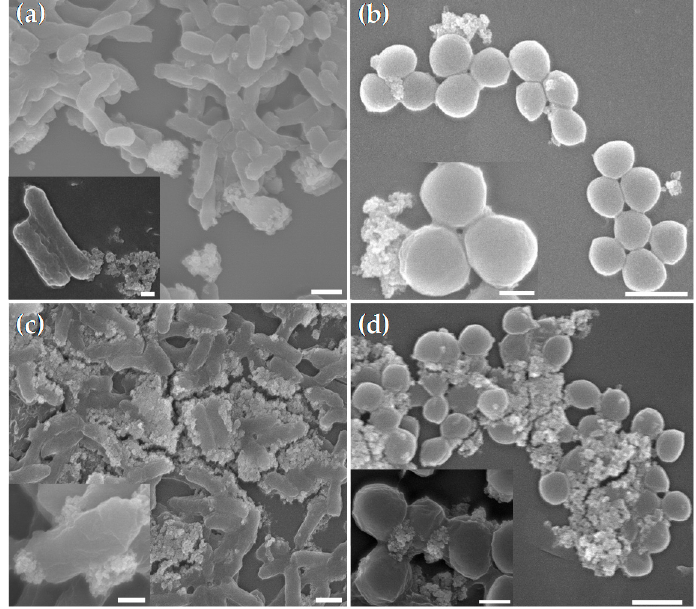
Figure 6. SEM images of ( a ) MNPs incubated with E. coli . ( b ) MNPs incubated with S. aureus . ( c ) CS-MNPs incubated with E. coli and ( d ) CS-MNPs incubated with S. aureus . Scale bars indicate 1 µ m. In the insets, scale bars indicate 0.3 µ m.